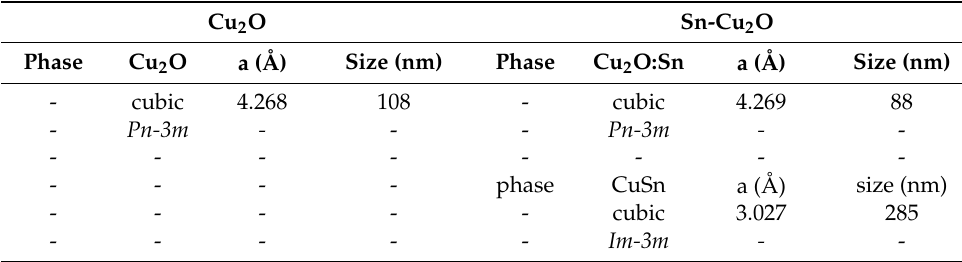
Table 1. Parameters obtained from Rietveld refinement for the Cu 2 O and Sn-Cu 2 O samples.